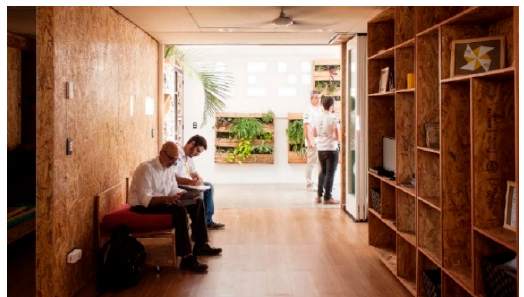
Figure 12. Photo of the hallway as seen from inside the prototype.